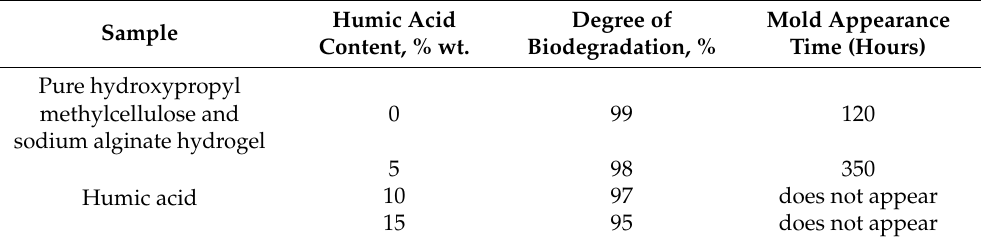
Table 3. Characterization of the mold appearance time and the degree of biodegradation of HESBHM based on hydroxypropyl methylcellulose and the humic acid